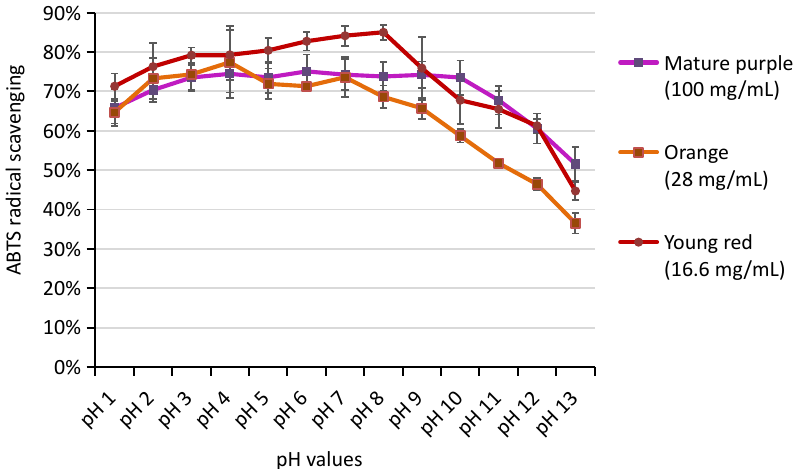
Figure 5. ABTS radical scavenging percentage for BBEs at different pHs. The concentrations of the bract extracts were shown in the brackets for each material.